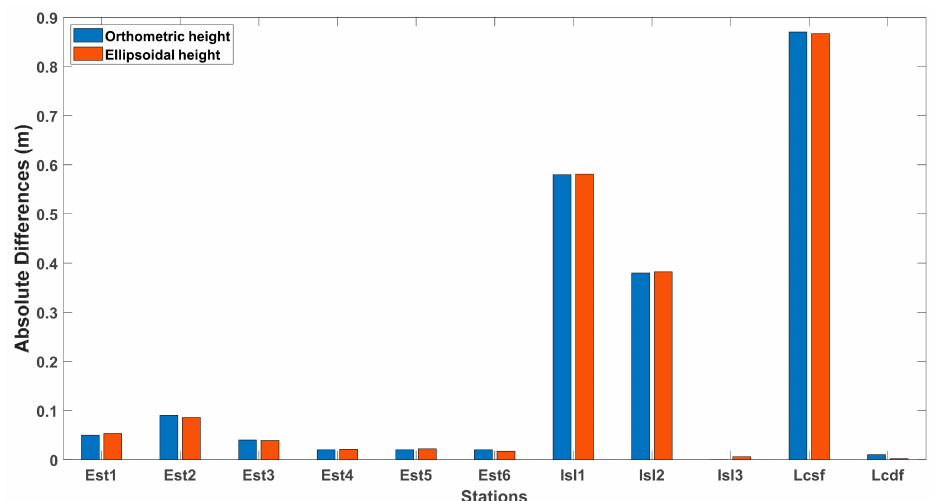
Figure 14. Absolute differences between orthometric height and ellipsoidal